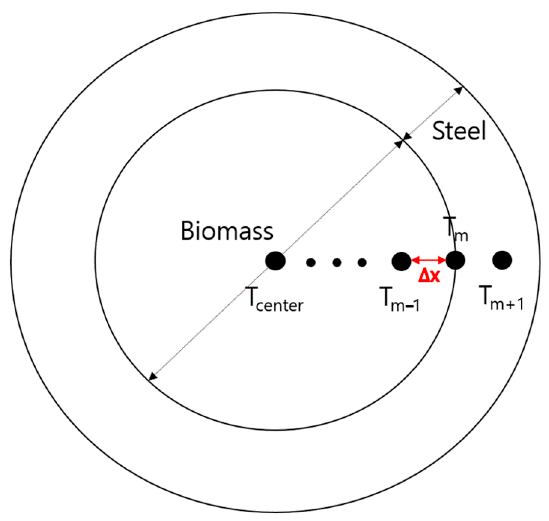
Figure 3. Finite element analysis to predict each node temperature in prototype capsule.